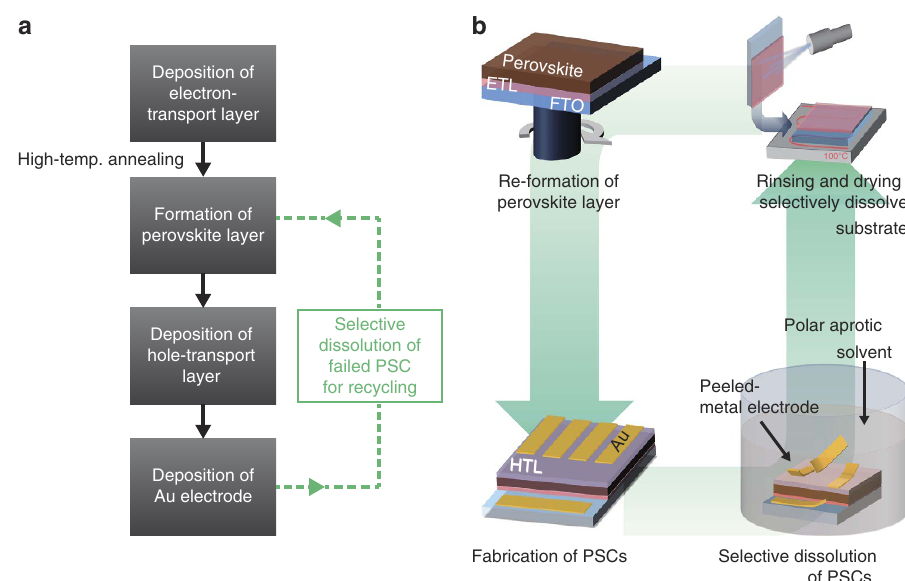
Figure 1 | Recycling process for PSCs. ( a ) Flow chart of the fabrication and recycling processes for PSCs. ( b ) Schematic illustration of the detailed process of recycling PSCs via selective dissolution. During soaking in a polar aprotic solvent, the deposited-metal electrode peels away from the device, leaving the clear electron-transport-layer-coated substrate behind, and the hole-transport layer and perovskite layer